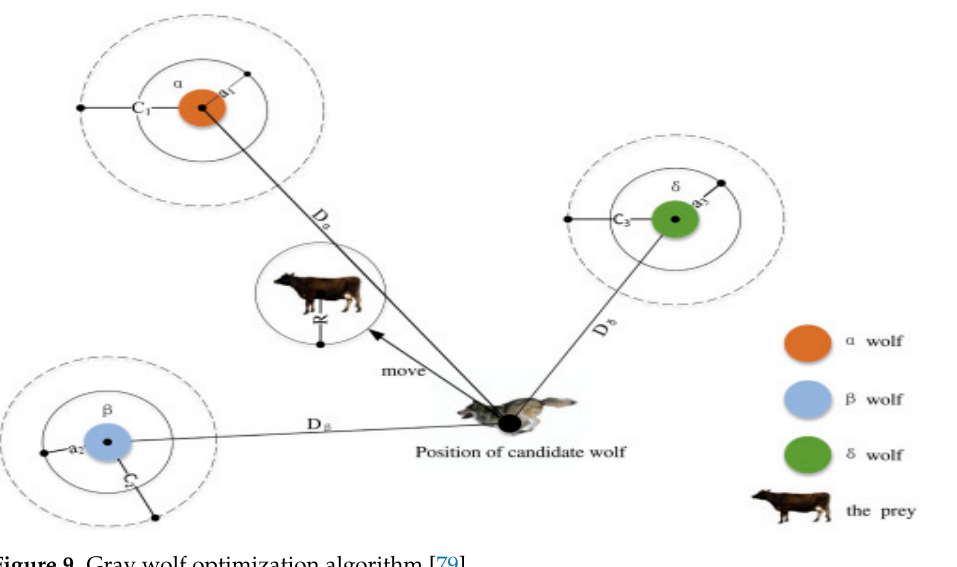
Figure 9. Gray wolf optimization algorithm [79].